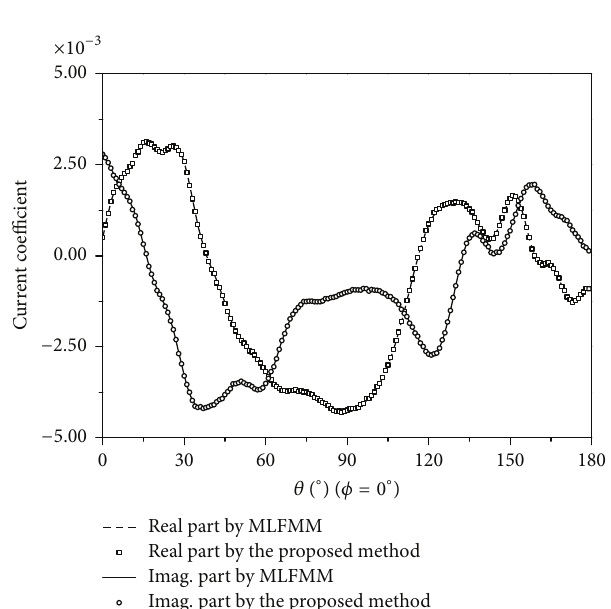
Figure 6: True and recovery current coefficients for missile model.